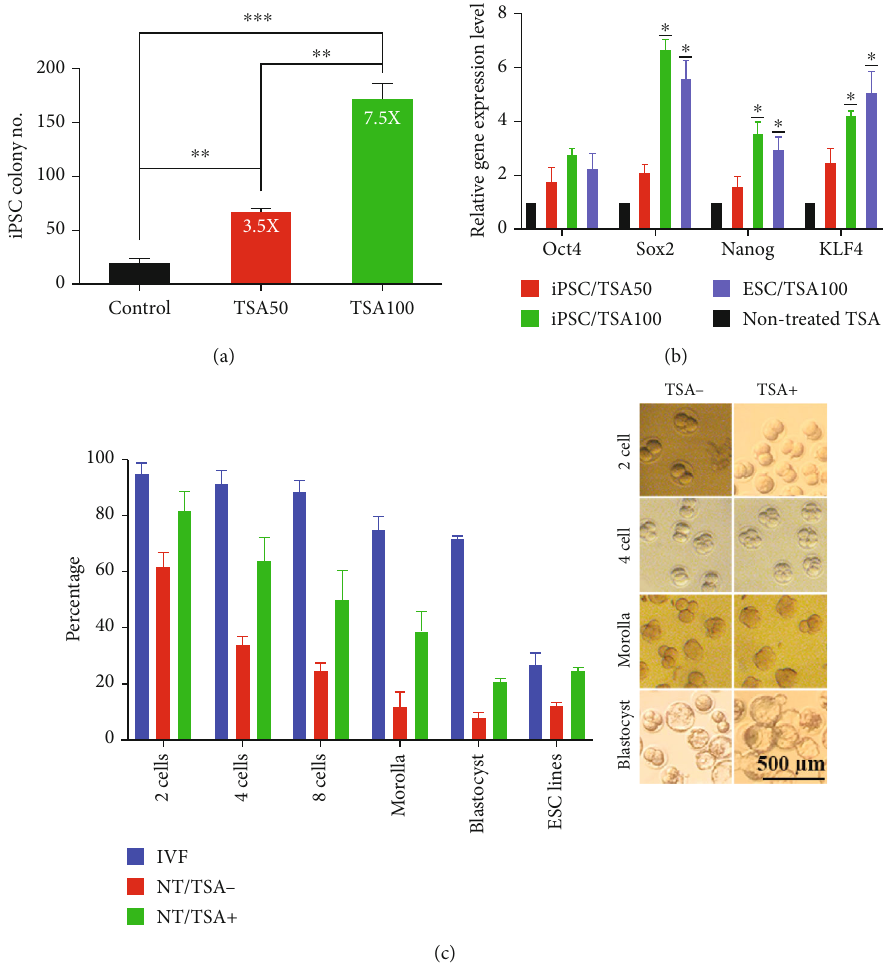
Figure 3: PSC ’ s generation e ffi ciency. (a) iPSC colony numbers showed that TSA treatment increased iPSC colony formation. (b) Pluripotency genes were evaluated by real-time PCR in di ff erent samples of iPSCs and ESCs. (c) Rate of embryo development and ESCs generation. ∗ , ∗∗ , and ∗∗∗ indicate the statistical signi fi cance, P < 0 : 05 , P < 0 : 01 , P < 0 : 001 , respectively, compared to the control